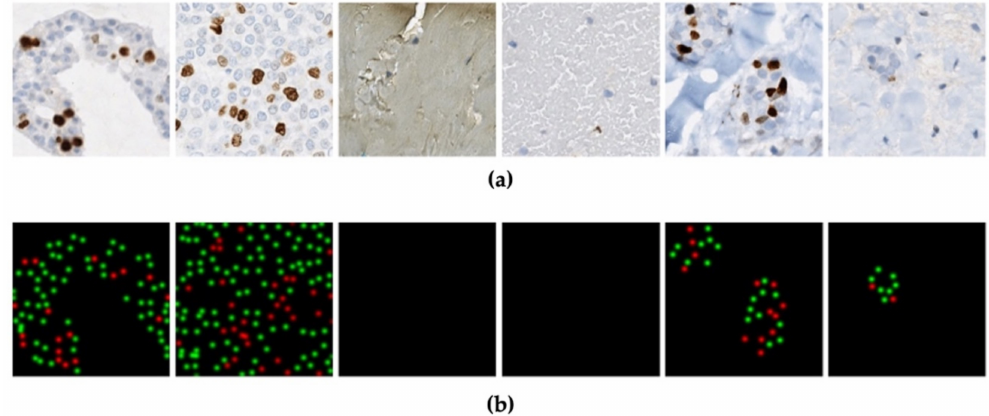
Figure 6. Array of ROIs from the SMH dataset. ( a ) Sample patches (ROI), ( b ) corresponding tumor cell proximity maps (red is Ki67+, green is Ki67 − and black is the